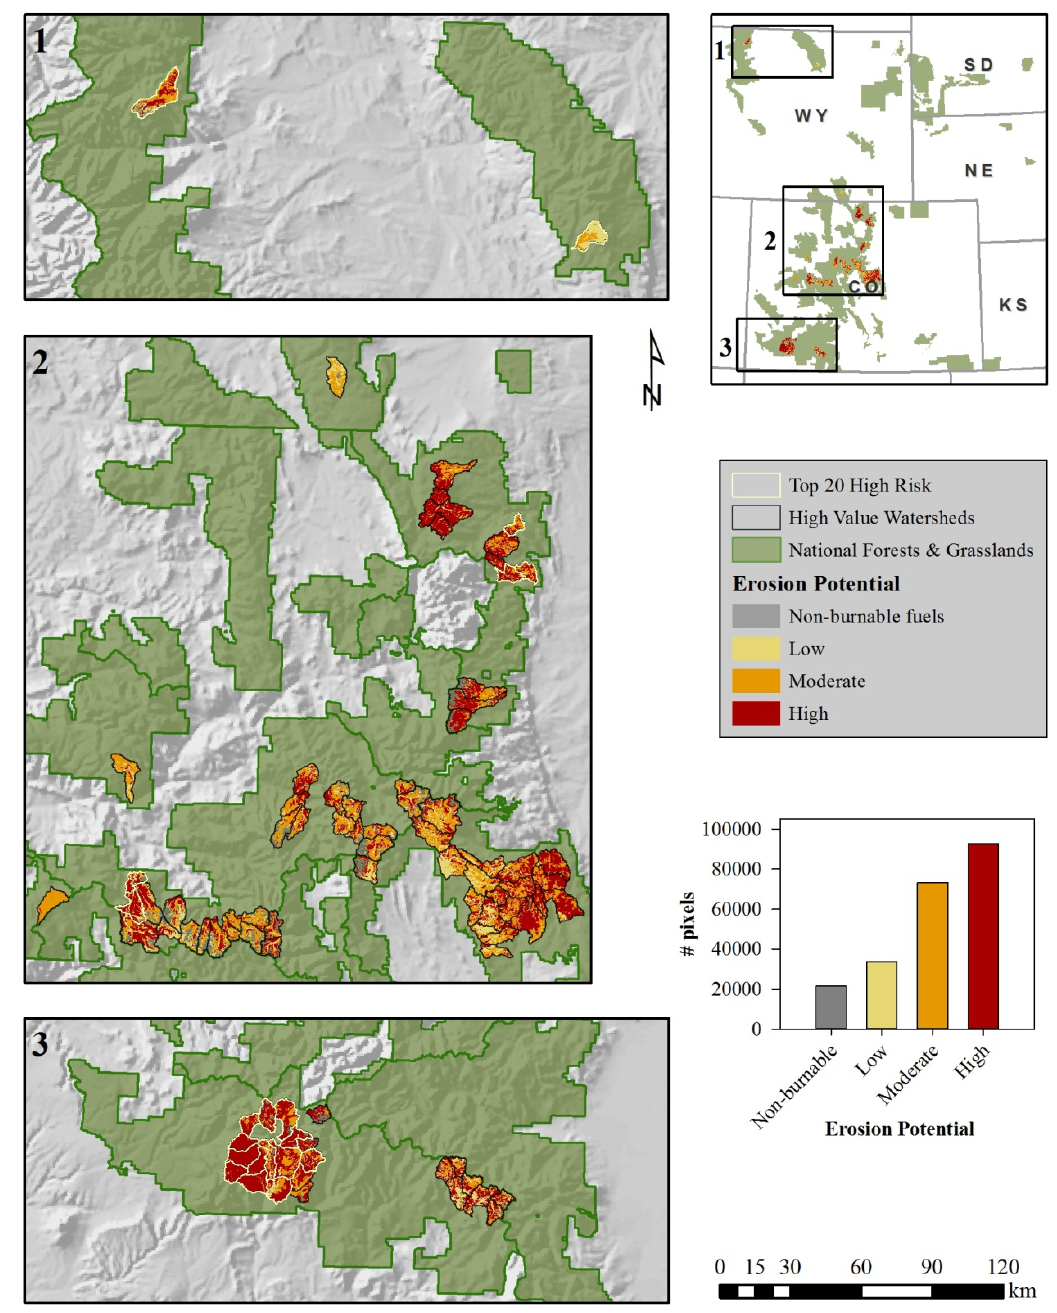
Figure 5. Erosion Potential categories mapped across the assessed high value watersheds, with the top 20 high risk watershed boundaries identified. CO = Colorado; KS = Kansas; NE = Nebraska; SD = South Dakota; WY =